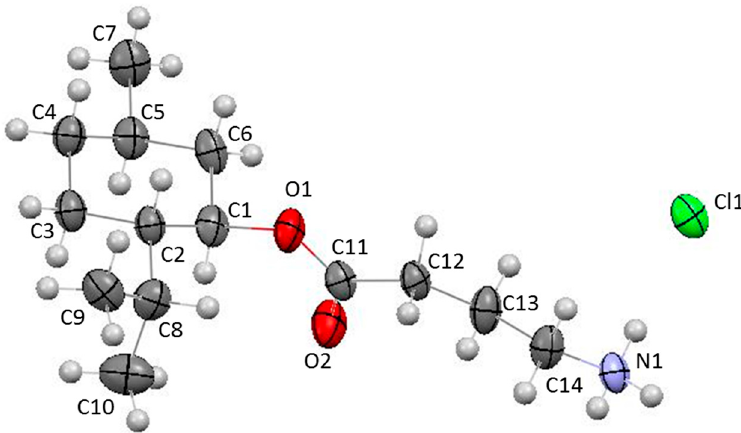
Figure 1. The molecular structure of (1 R ,2 S ,5 R )-2-isopropyl-5-methylcyclohexyl 4-aminobutyrate hydrochloride according to X-ray diffraction data. All atoms are represented by 50% probability ellipsoids.